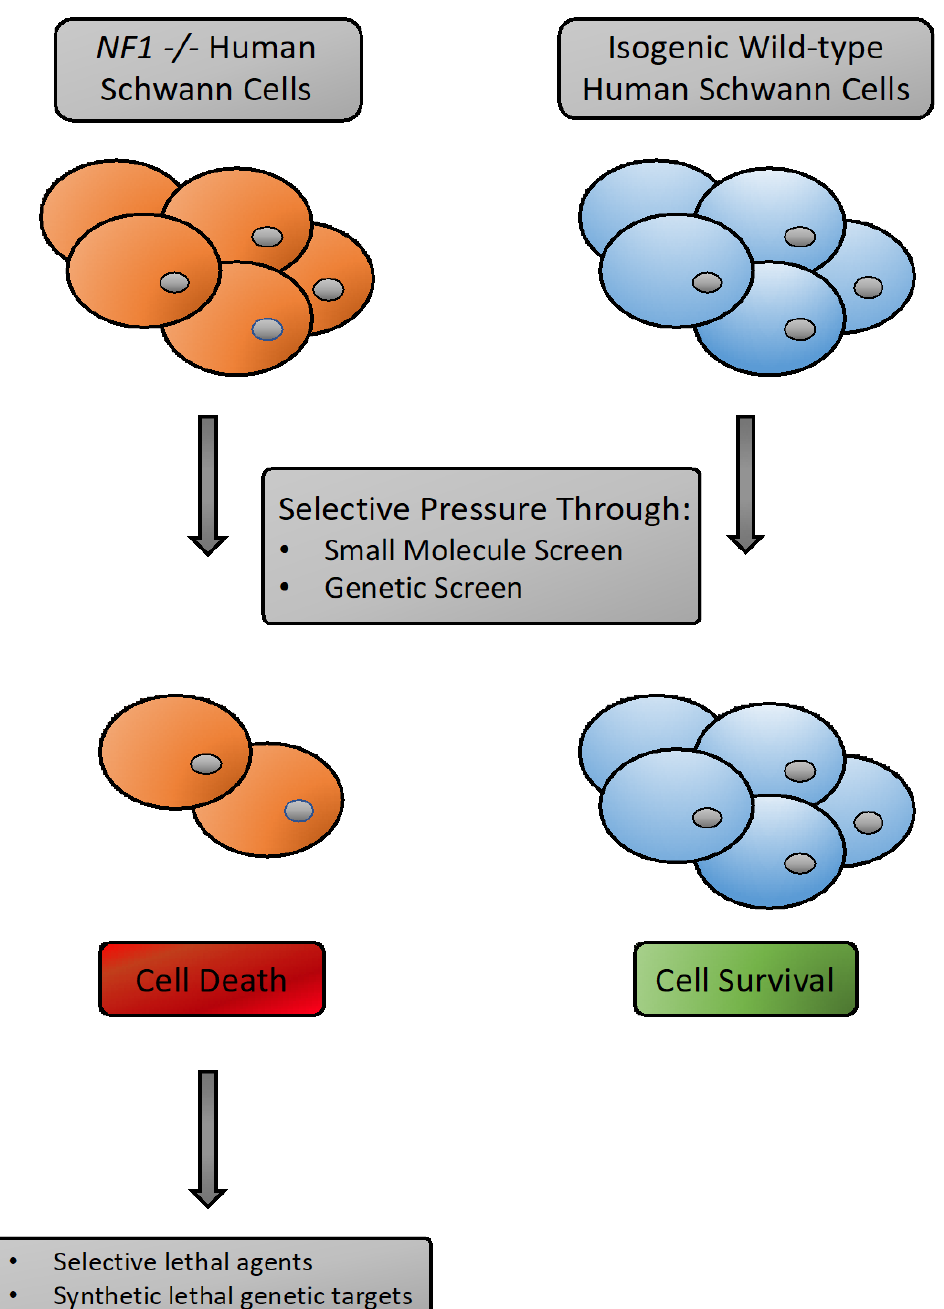
Figure 2. Screening scheme utilizing NF1- deficeint immortalized or iPSC derived human Schwann cells. NF1 − / − cells (of either origin) and their isogenic match parental lines can be used in selective lethal pharmacologic screens or synthetic lethal genetic screens. Compounds found to only kill NF1- deficient cells could be then prioritized for further preclinical testing, using in vivo models of MPNST for example. Novel genetic targets identified from genome-wide synthetic lethal genetic screens could provide the basis for additional drug discovery efforts.